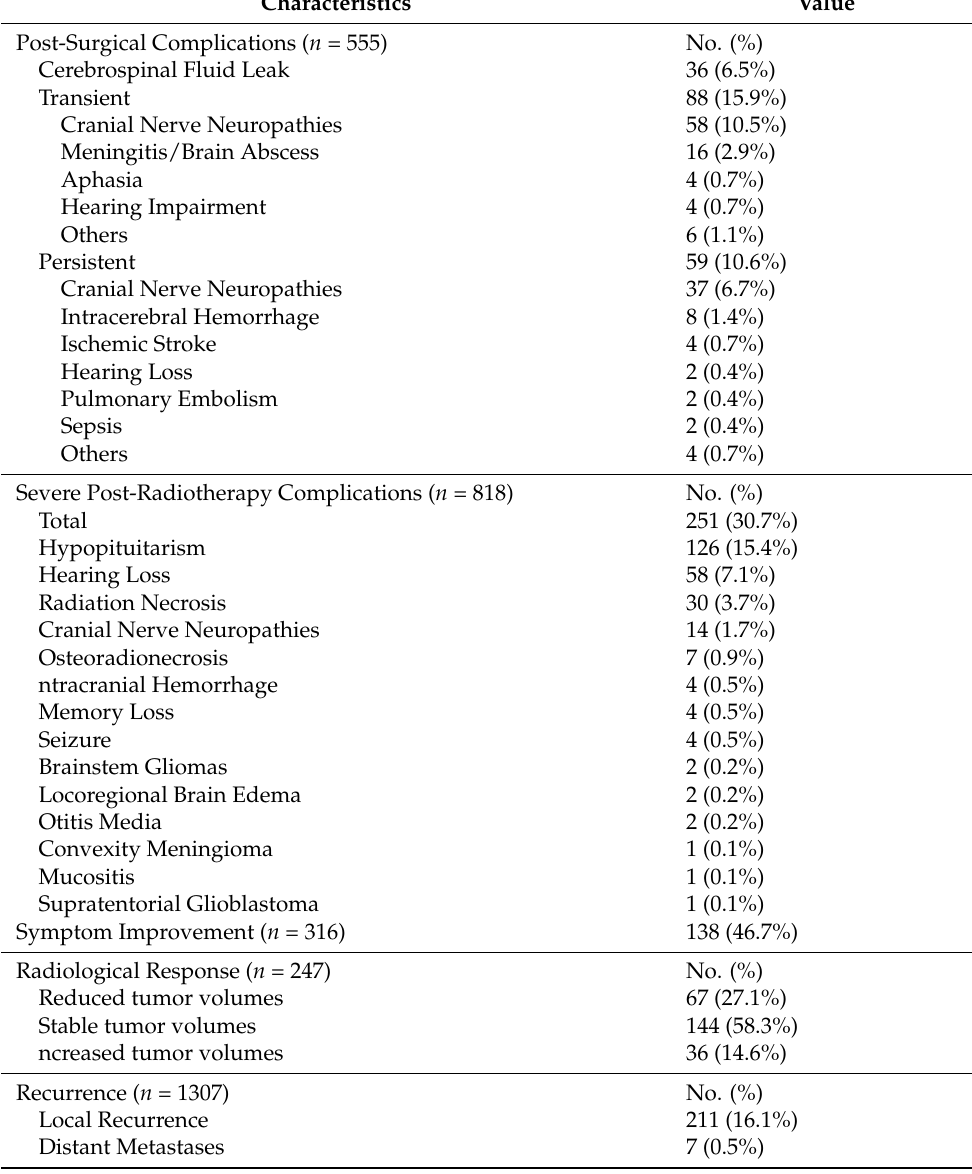
Table 4. Summary of treatment outcomes of all pooled